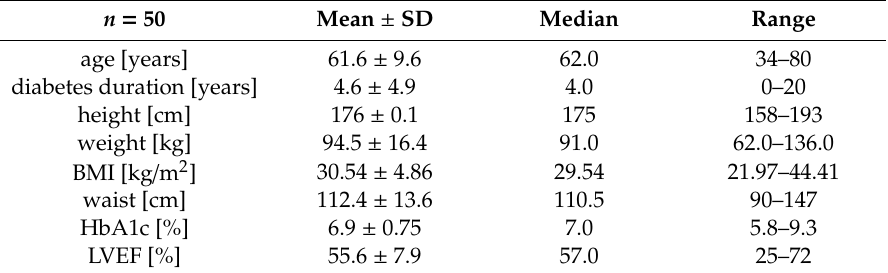
Table 1. Basic patient data.